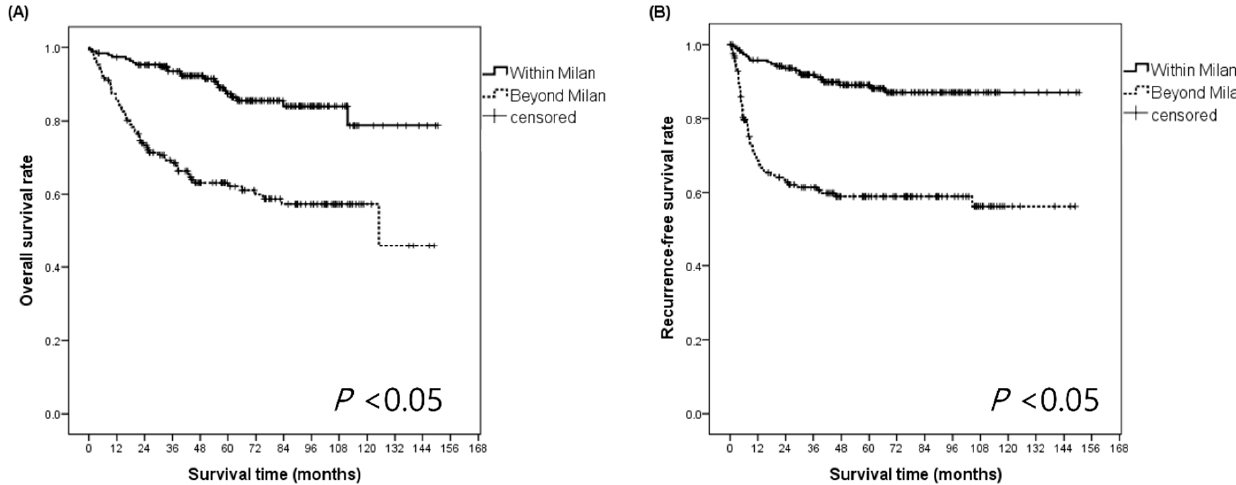
Figure 2. Comparison of the overall survival rates and recurrence-free survival rates for patients with HCC assessed according to the Milan criteria. ( A ) The overall survival rates at 1, 3, and 5 years for WM patients were 97.4%, 93.5%, and 87.3%, respectively; those for BM patients were 85.6%, 69.4%, and 64.1%, respectively ( B ) The recurrence-free survival rates at 1, 3, and 5 years for patients within the Milan criteria were 95.7%, 90.4%, and 87.6%, respectively; those for patients beyond the Milan criteria were 68.6%, 61.2%, and 57.8%, respectively. BM, beyond the Milan criteria; HCC, hepatocellular carcinoma; LDLT, living-donor liver transplantation; WM, within the Milan criteria.